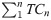
Simulated T cell clonal growth variability in SCT DRP.A. Tissue specific simulated alloreactive T cell counts after 500 iterations in recipients of MRD (Black line) and unrelated donors (Blue line). These values represent the sum of the entire T cell vector responding to the alloreactivity operator matrix of mHA-HLA complexes for a specific organ (∑1nTCn). Arrows denote individuals with T cell responses differing by orders of magnitude. Values were obtained by calculating the average for iteration number 401–500 due to variability from competition. Simulation data were available for 73 patients. B & C. Variation in the simulated alloreactive T cell counts observed for each organ examined between patients (3B) and within patients (3C). Note Log scale used in Figure 3B, but not in 3C (Y axis truncated at 130000). D. Total, simulated alloreactive T cell counts in recipients of MRD and unrelated donors after 500 iterations (average for iteration number 401–500 due to variability from competition). P value for magnitude difference, >0.3.